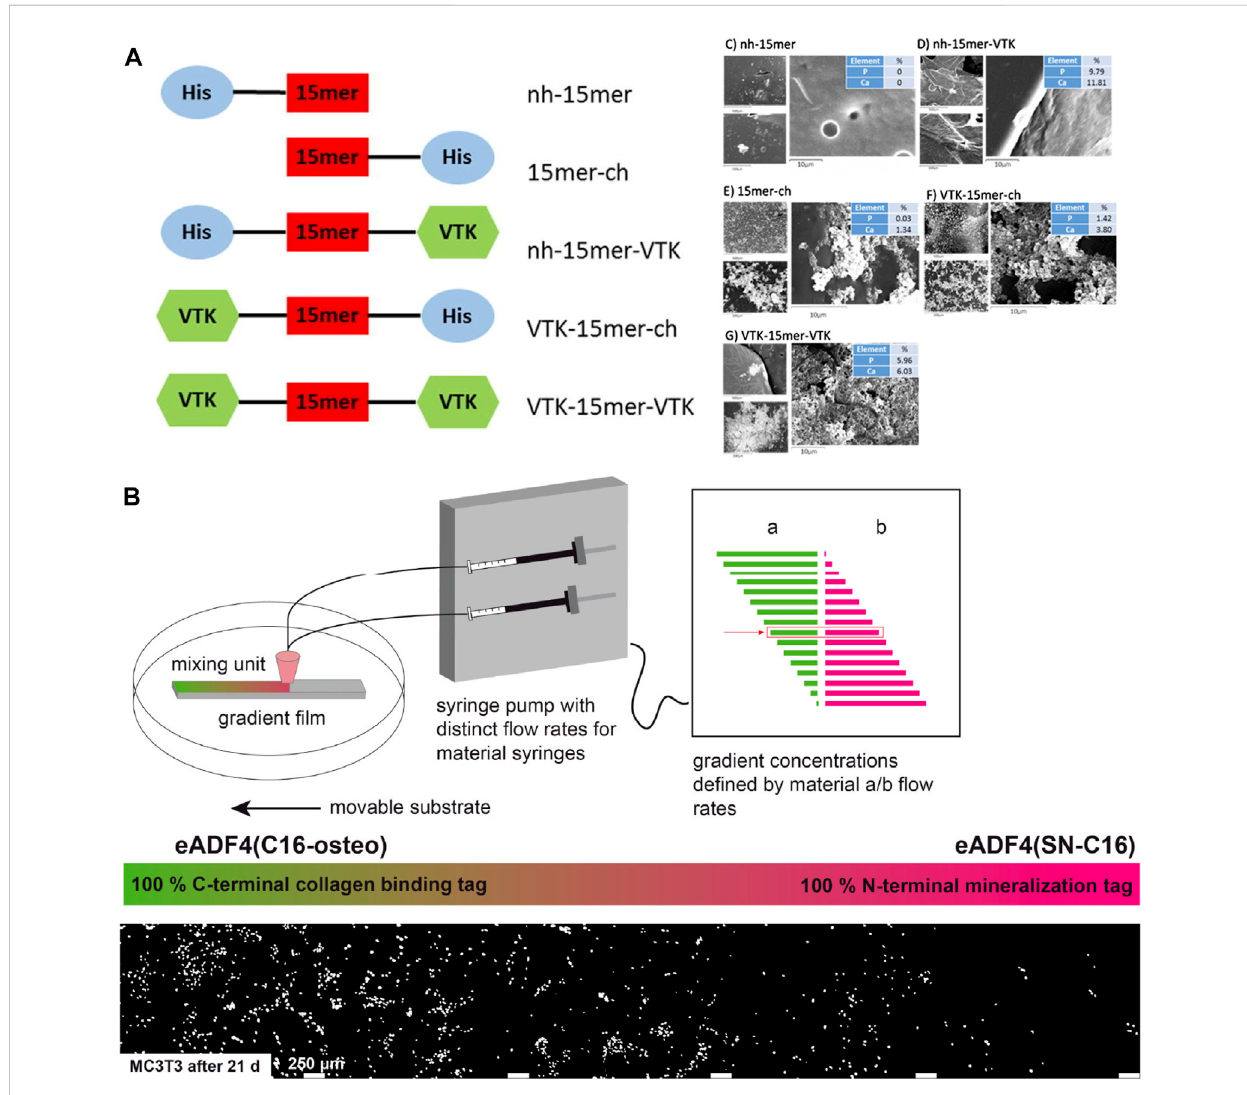
FIGURE 7 Mineralization and cell adherence of genetically engineered silks. (A) Silk-VTK fusion proteins and fi lms for enhanced mineralization. (B) Spider silk – SIBLING hybrids showed enhanced calcium phosphate formation and preferentially adherence of pre-osteoblasts along the gradient toward the variant with a collagen-binding motif. Adapted with permission from ref (Dinjaski et al., 2017) (Neubauer and Scheibel, 2020) Copyright 2017 Elsevier, 2020 American Chemical